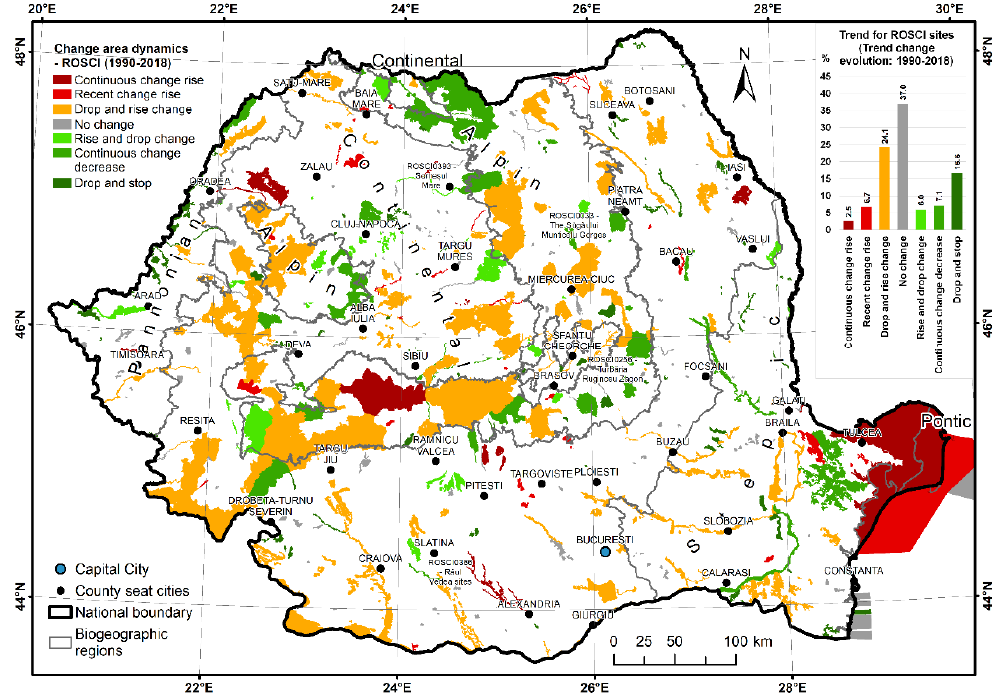
Figure 8. Distribution of the different patterns of dynamic behavior for ROSCI (1990–2018). In the case of ROSPA sites, unlike ROSCI sites, the highest weight is given by “Drop and rise change” with 43%, followed by “Drop and stop” with 20%, and 13% for scenario “No change”. In these areas, the “Recent change rise” scenario has 6%, and “Continuous change rise” only 1%, while “Rise and drop change” 4%, and “Drop and stop” 21%. Regarding ROSPAs, a high share (of about 51%) of the scenarios in which the changes within the sites take place after 2006 can be observed, i.e., after the implementation of the Natura 2000 network in Romania (Figure 9).